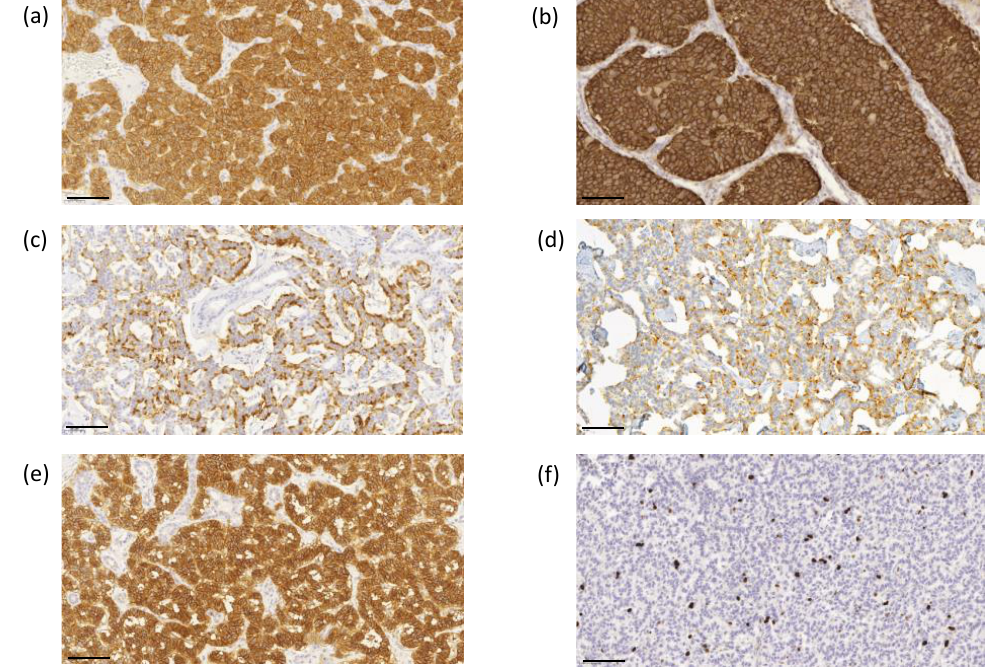
Figure 3. Representative images of immunohistochemical labeling of SSTR1-5 and Ki-67. SSTR1 ( a ) shows both membranous and cytoplasmic expression, whereas SSTR2 ( b ) and SSTR5 ( e ) expressions were mainly membranous. SSTR3 ( c ) and SSTR4 ( d ) show both membranous and cytoplasmic expression, often luminal. Ki–67 ( f ) expression was located in the nucleus. Images were obtained by the CaseViewer software 2.4 (3D HISTECH, Budapest, Hungary) with a magnification of 20×. Scale bar 100 µm.